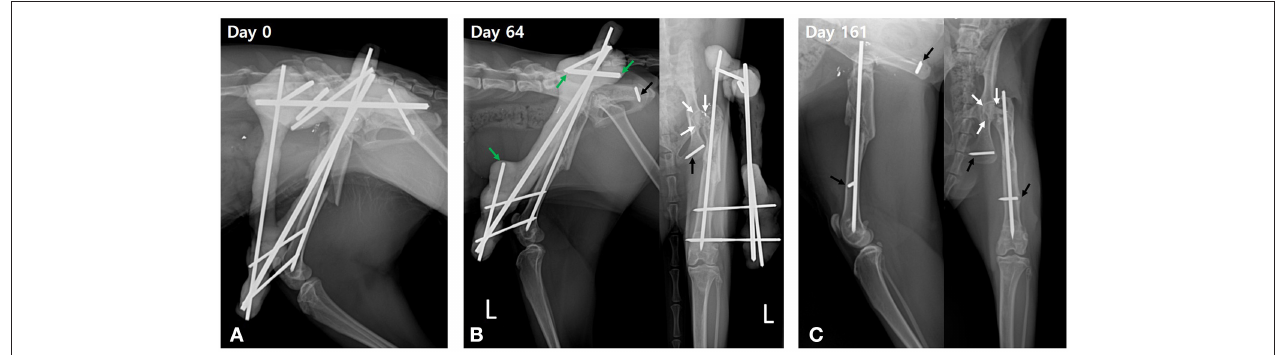
FIGURE 4 | Postoperative serial radiographic views of the left femur. (A) Lateromedial radiograph acquired immediately after surgery shows good alignment and normal length of the left femur with trans-articular external skeletal fixation of the hip and a tied-in intramedullary pin. (B) On postoperative day 64, periosteal callus bridges the femoral fracture gap with cortical remodeling. Heterogenous opacity of the femoral neck and greater trochanter are identified on the craniocaudal radiographic view (white arrows). Trans-articular external skeletal fixation of the hip is disassembled to the linear tie-in frame by removal of fixation pins in the left pelvis and the associated connecting bars. The connecting bars are cut at the linkage area (green arrows) to preserve the linear tie-in frame. The fixation pin in the ischium is broken and partially embedded in the ischium (black arrow). (C) On day 161, the whole frame of the external skeletal fixation is removed, leaving the intramedullary pin and embedded part of the broken pins (black arrows). Fracture union showing good progression in bone healing is identified as a heterogeneous opacity with a mottled appearance at the femoral head and neck (white arrows).